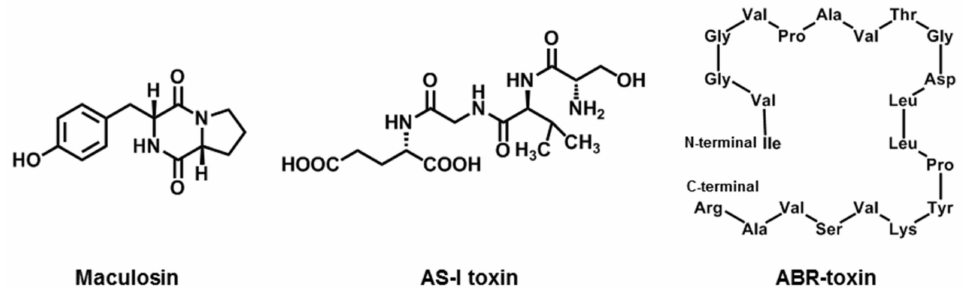
Figure 5. Chemical structures of maculosin, AS-I toxin, and